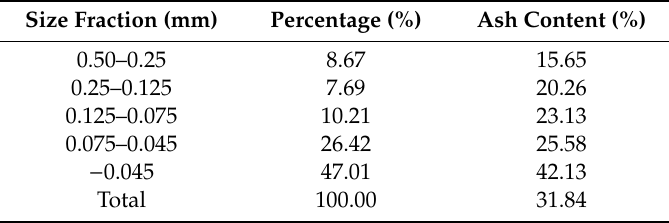
Table 2. Particle size distribution of LRC sample.